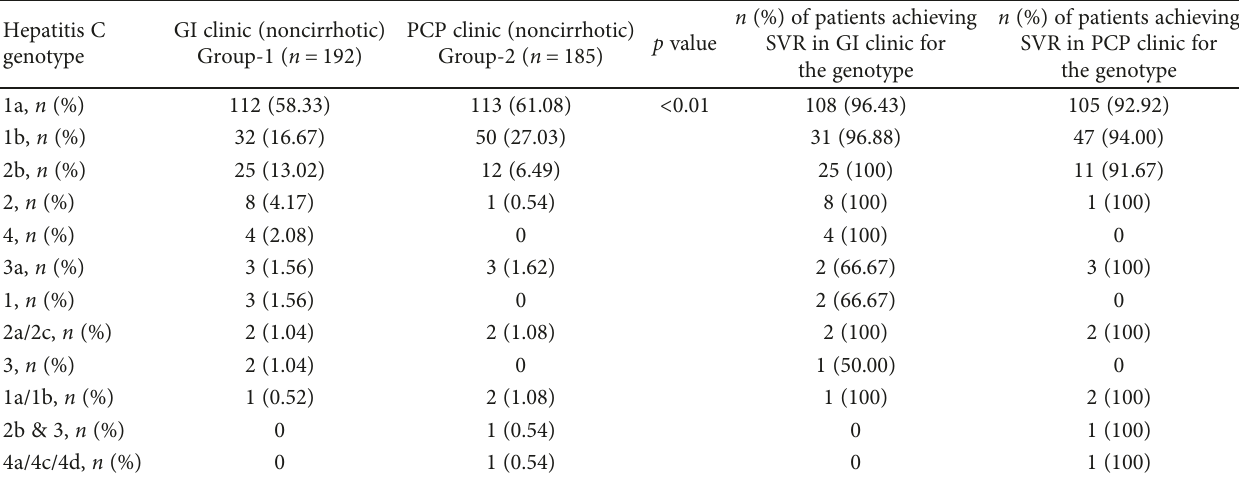
Table 5: SVR outcomes based on the hepatitis C